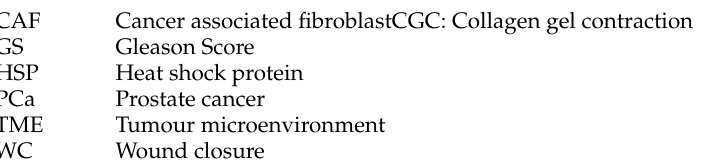
Figure S1: Histology of CAF/BPH1 tumours after treatments with HSP90 inhibitors in vivo, Figure S2: Contractility of CAF from patients of different age and Gleason grade, Figure S3: Reconstituted tumour sizes from CAF showing minimal and maximal contractility, Figure S4: Effects of Dorsomorphin upon CAF contractility, Figure S5: Effects of HSP90 inhibitors upon cellular levels of HSP27, Phospo-HSP27, and HSP60, Table S1: Collagen contractility and Gleason grade and patient age, Table S2: Tumour size elicited by most versus least contractile